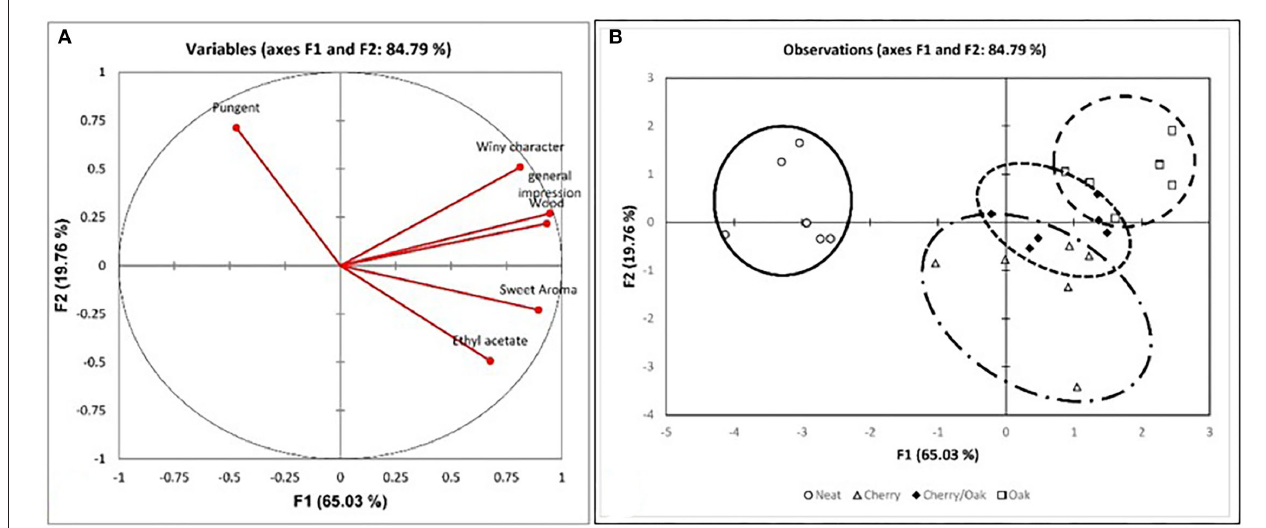
FIGURE 4 | PCA analysis for the sensorial parameters for the six matrices by treatment, i.e., control and three wood treatments. (A) Variables plot for the sensorial parameters with a total variance of 84.79%; (B) observations plot of the four vinegar samples (control and the accelerated wood-aged vinegar samples) for the six matrices.